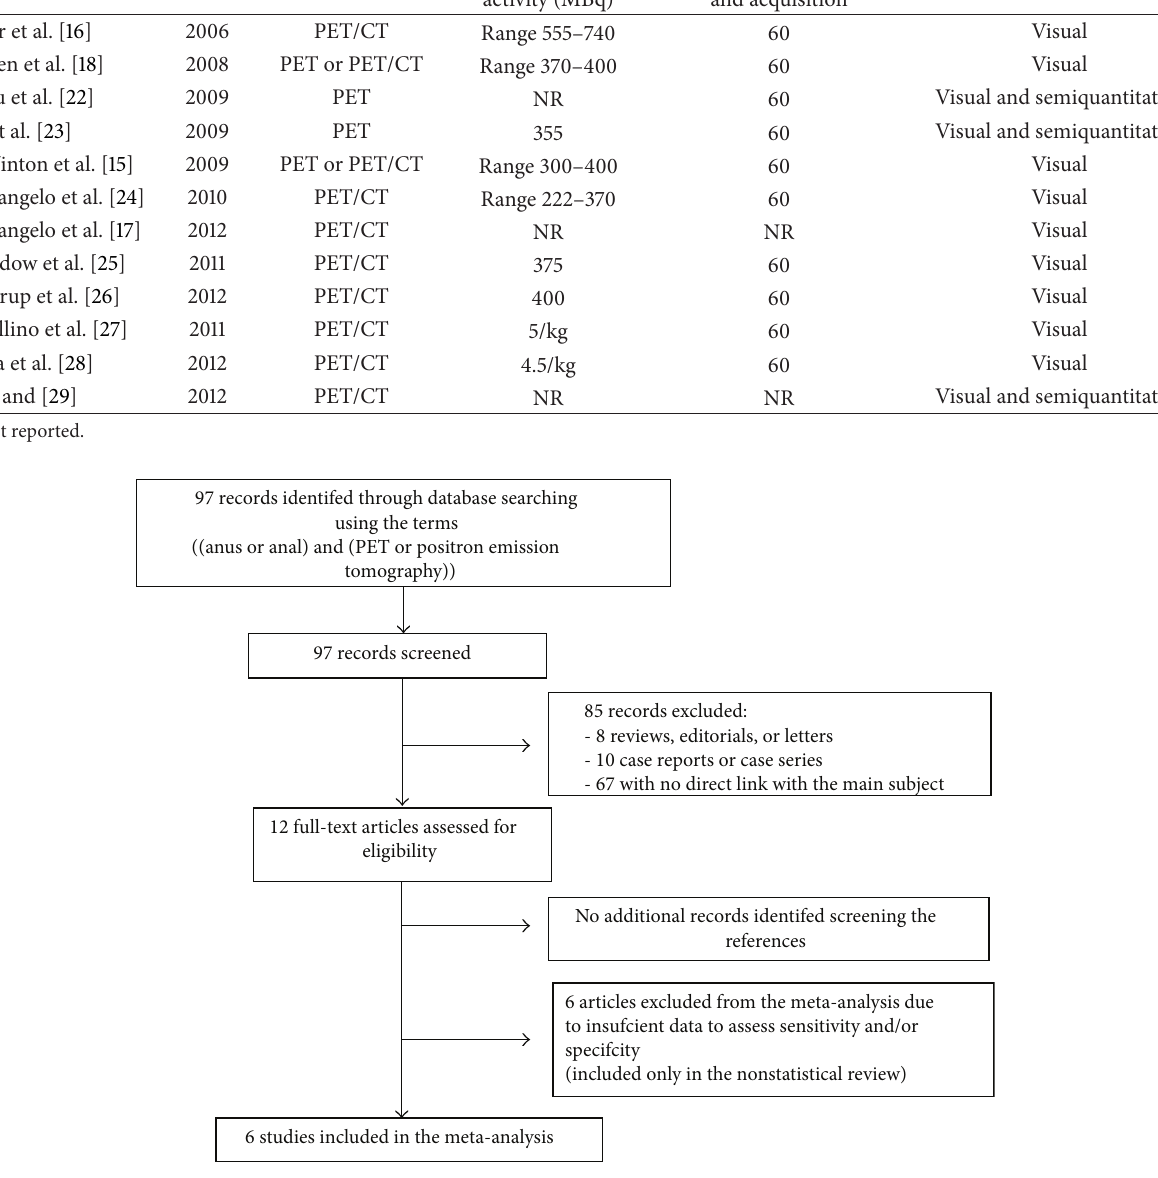
Figure 1: Flowchart of the search for the eligible studies on the diagnostic performance of FDG PET/CT in detecting locoregional node involvement in patients with